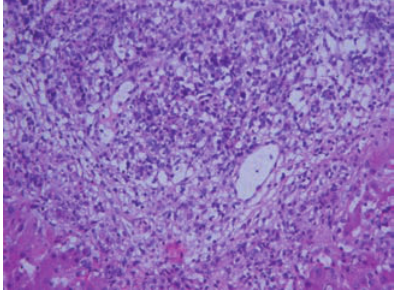
Figure 1. Portal infiltrate by Hodgkin’s and pleomorphic Reed-Sterberg cells in the liver. (Hematoxylin-and-eosin stain; 200X